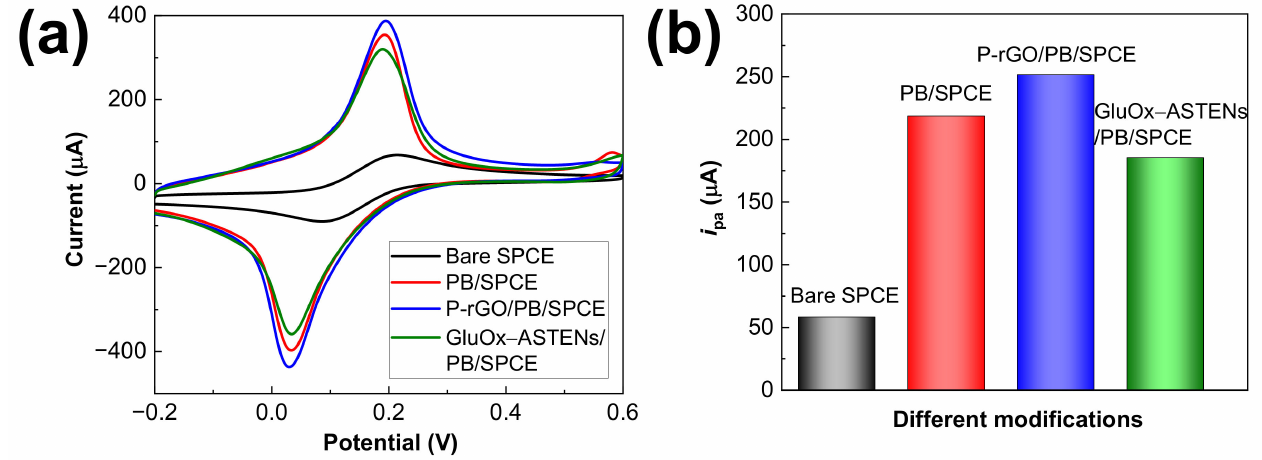
Figure 2. ( a ) Cyclic voltammograms of various biosensors in the presence of 5 mM K 3 [Fe(CN) 6 ] in 0.1 M KCl at a scan rate of 50 mV s − 1 ; ( b ) corresponding i pa